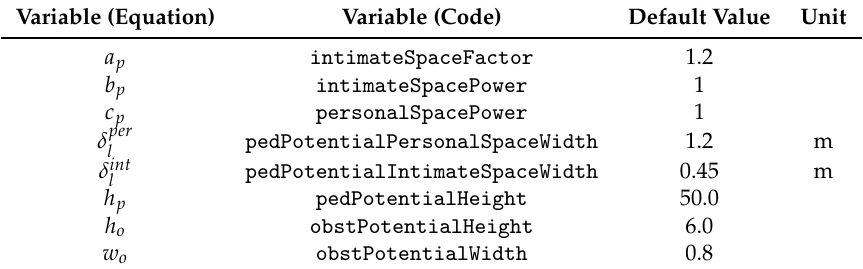
Table A1. Mapping between the notation in the Vadere code and the mathematical description of the utility functions. Variable (Equation) Variable (Code) Default Value Unit a p intimateSpaceFactor b p c